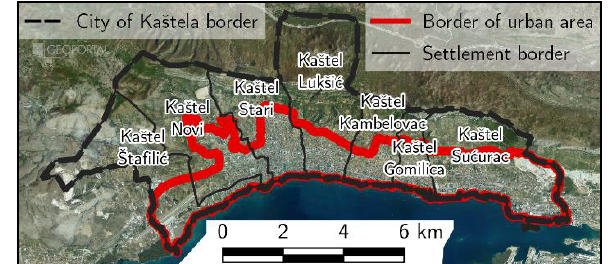
Figure 1. The study area of the City of Kaštela with seven settlements (aerial imagery © State Geodetic Administration of Croatia) For the study area, planned land use and administrative borders were obtained from the official General urban plan (City of Kaštela, 2012) in scale 1:10,000. Green areas are present in the urban areas and considered under several categories of planned land use (City of Kaštela, 2012). Their mappings to the typology of GI and area they cover are given in Table 1. In total, they cover 4.99 km2 and that is 20.54 % of the urban area.